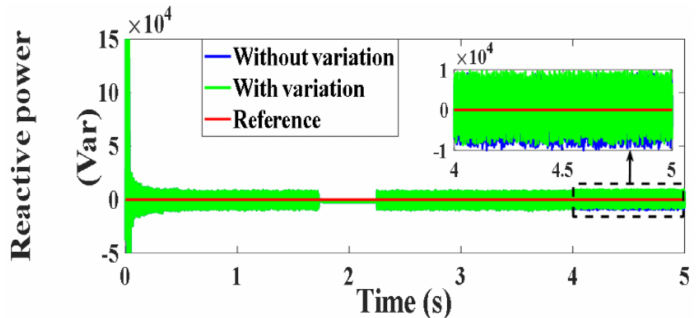
Figure 140. Reactive power under PVC (var).